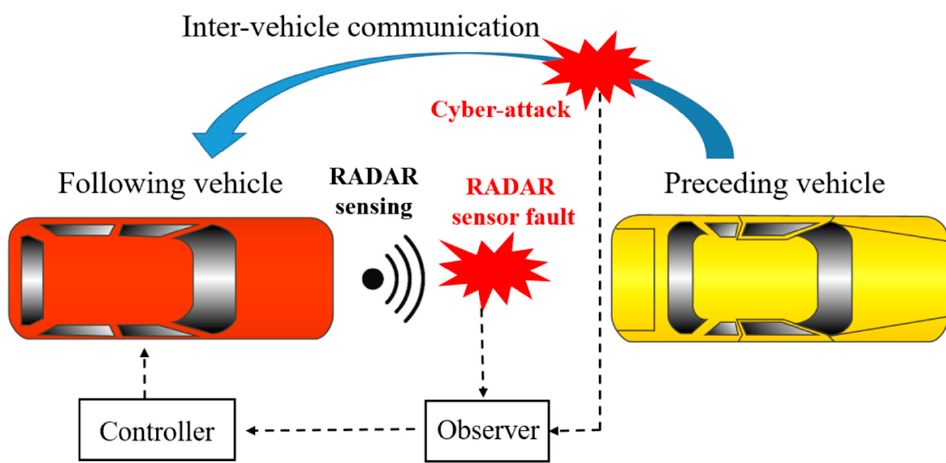
Figure 9. Fault diagnostics for radio detection and ranging (RADAR) and intervehicle communication system.